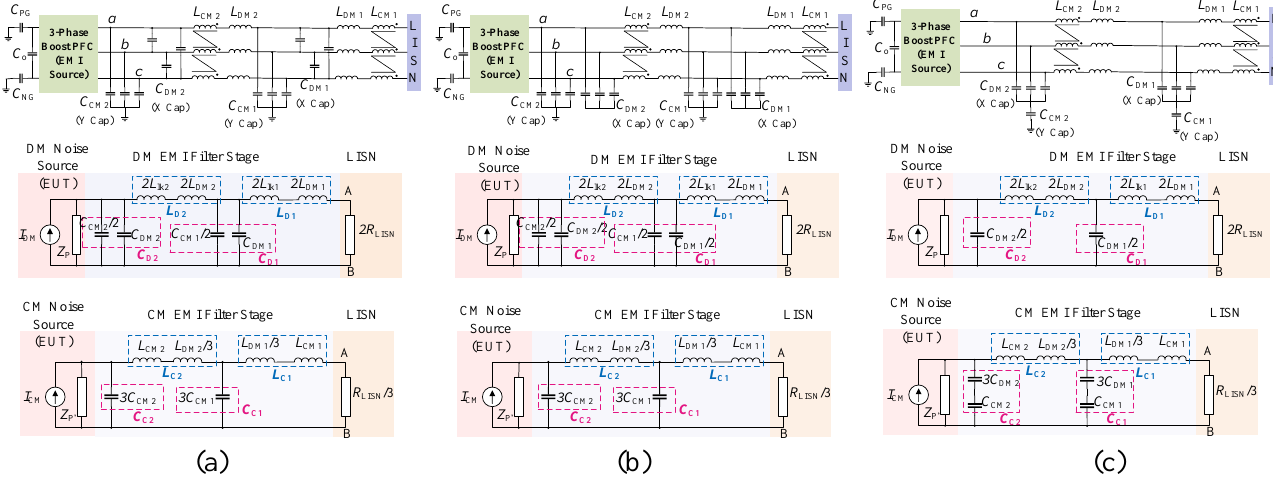
Figure 5. EMI filter structures under study and their corresponding DM and CM equivalent circuits: ( a ) filter structure 1; ( b ) filter structure 2; ( c ) filter structure 3.